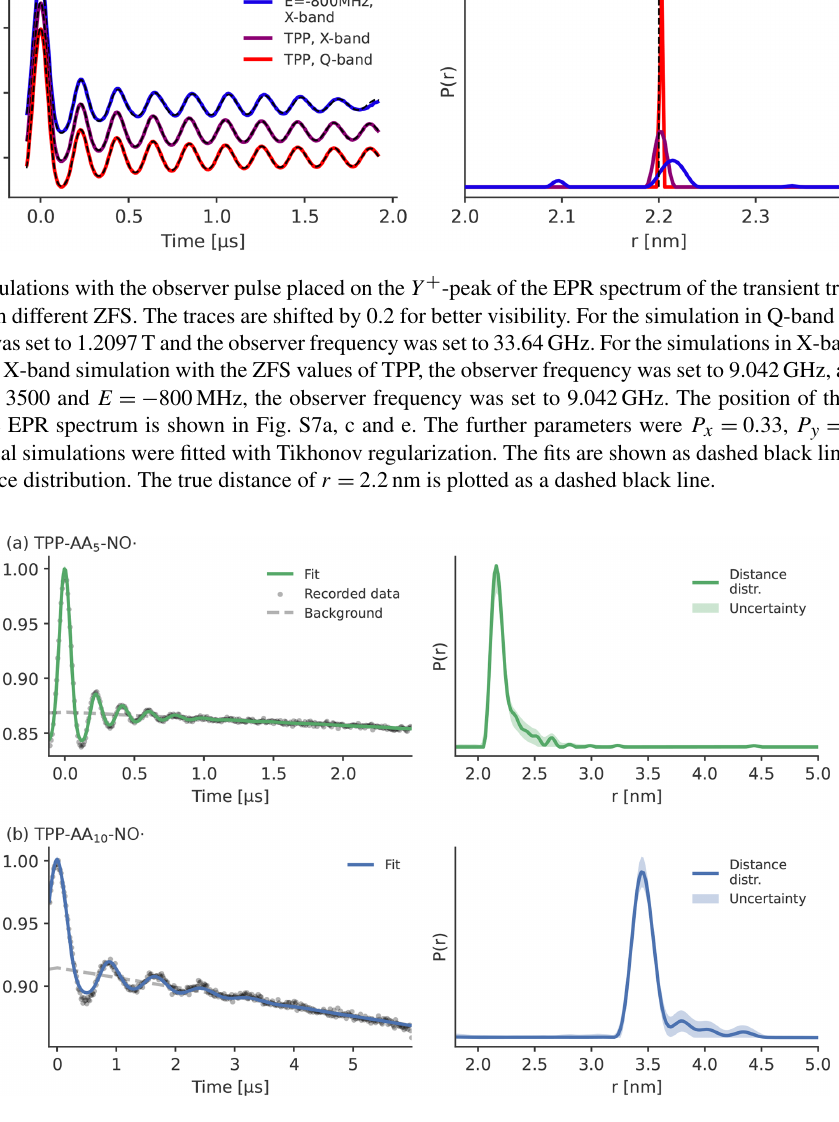
Figure 11. Experimental LiDEER data of the two peptides, all recorded in Q-band at 30K in MeOD / D 2 O (98 / 2vol%). Panel (a) shows (cid:113) (cid:113) TPP–pAA 5 –NO , and panel (b) displays TPP–pAA 10 –NO . The raw data are depicted on the left side as gray dots with the fits as a straight line, and the background fit is depicted as a dashed gray line. The distance distributions obtained with Tikhonov regularization (Fábregas Ibáñez et al., 2020) are shown on the right side. The shaded areas correspond to the 95% confidence intervals that were obtained with